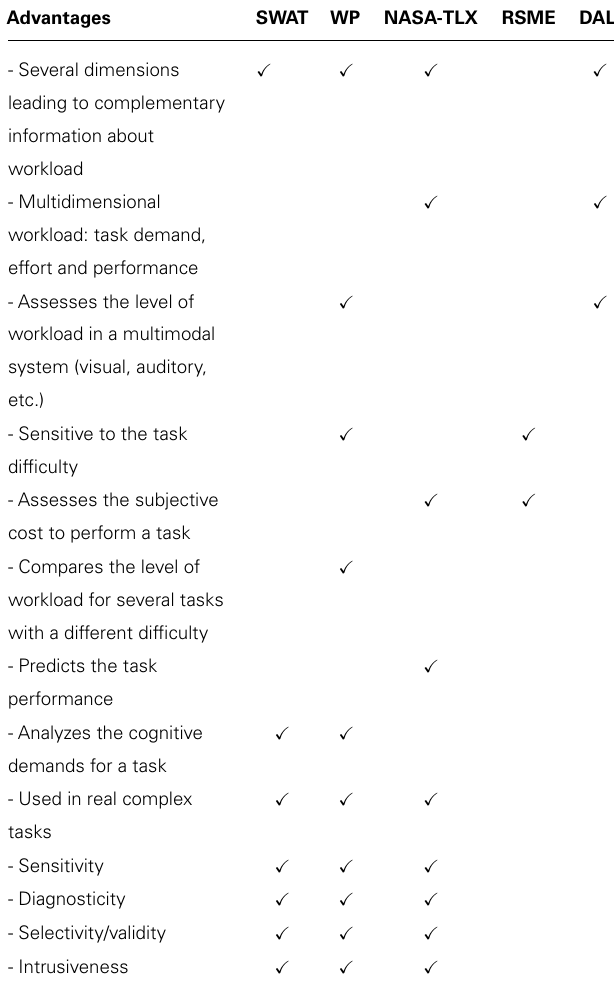
Table 1 |Advantages of workload